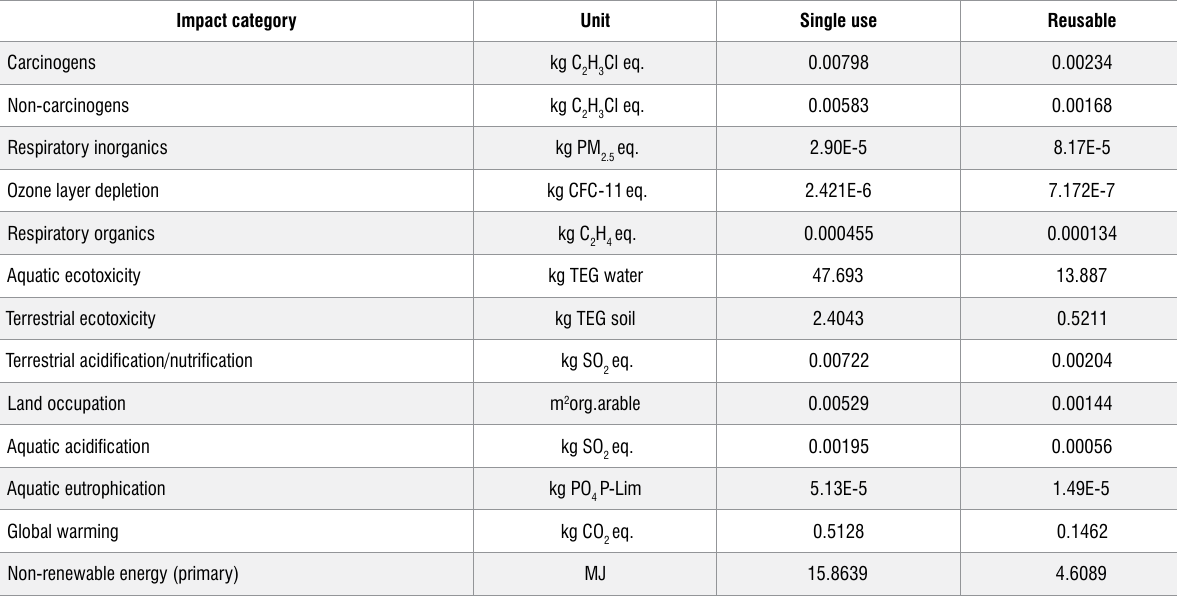
Life cycle assessment impacts of PET bottles in the different phases